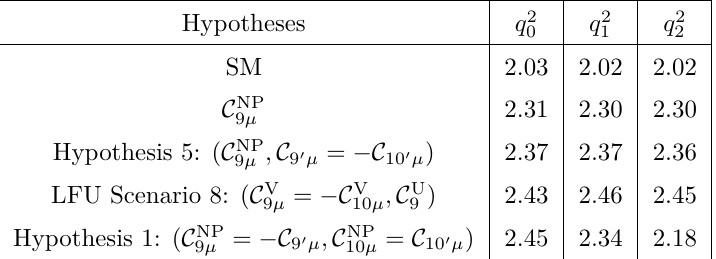
)) = Re( A ( q 2 )) , b) position of P max ( q 2 ) k 0 0 2 1 ) . This shows that only in the presence of right handed 2